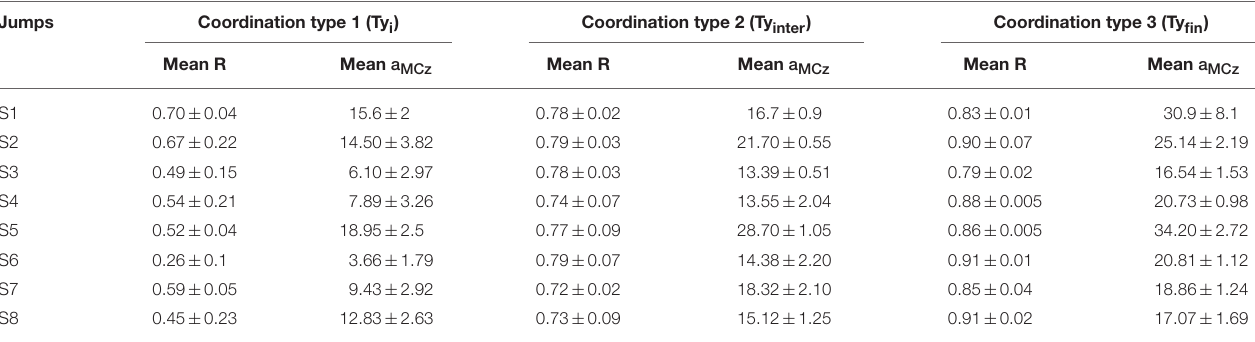
TABLE 2 | Means values of R of a MCz (m/s 2 ) as function of the coordination type. Jumps